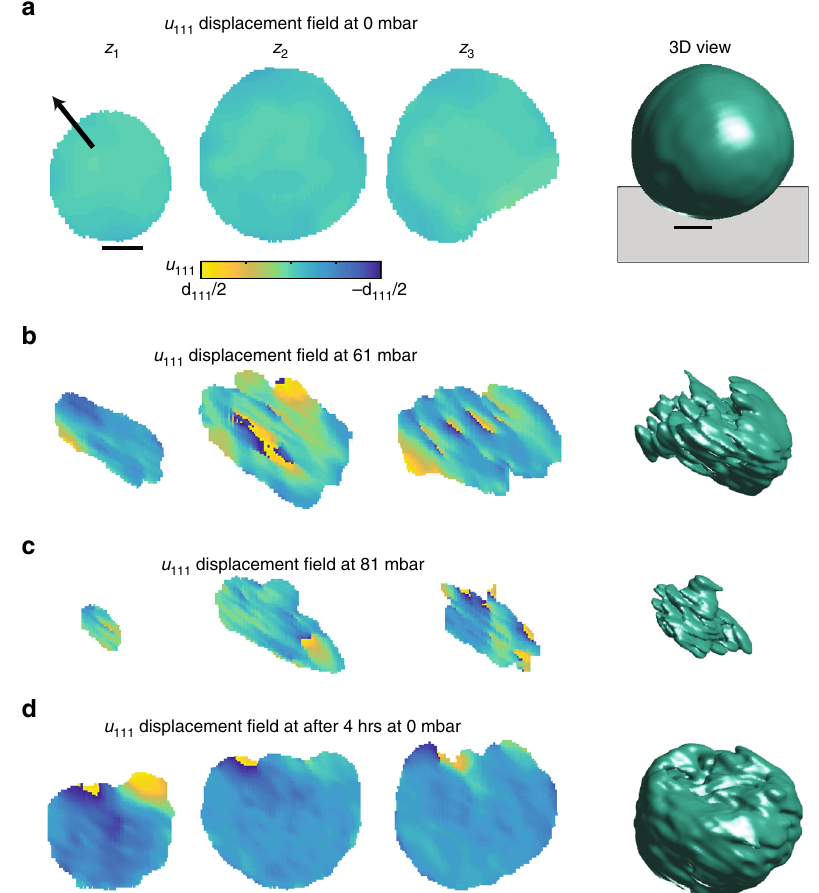
Fig. 1 3D Imaging of the displacement fi eld of an individual Pd nanoparticle self-healing defects. Three cross-sections of the u 111 displacement fi eld through the particle volume (see Supplementary Fig. 2 for their spatial location) and the 3D view are shown. The scale bars represent 100 nm. a The Pd nanoparticle shape in the as-synthesized state. The displacement fi eld cross-sections z 1 – z 3 show the particle is nearly strain-free and has no defects visible at this scattering condition. The black arrow shows the [111] direction. The 3D view shows the particle is approximately spherical. The grey plane in the 3D view indicates the substrate. b The phase transformation is driven by incrementing the hydrogen partial pressure in a step-wise fashion. At 61 mbar pH 2 , regions that have transformed to the hydrogen-rich phase appear missing. Dislocations are induced in the hydrogen-poor phase due to the lattice mismatch between the two phases. The location of displacement fi eld vortices corresponds to the dislocation cores. c Increasing pH 2 to 81 mbar results in more regions transforming to the hydrogen-rich phase and dislocation rearrangement. d The phase transformation is reversed by applying 0 mbar of hydrogen partial pressure. After 4 h, the particle has almost completely returned to the hydrogen-poor phase. More importantly, the dislocations that were induced in the particle ’ s center have healed. Only a few dislocations exist near the top of the particle, close to the phase